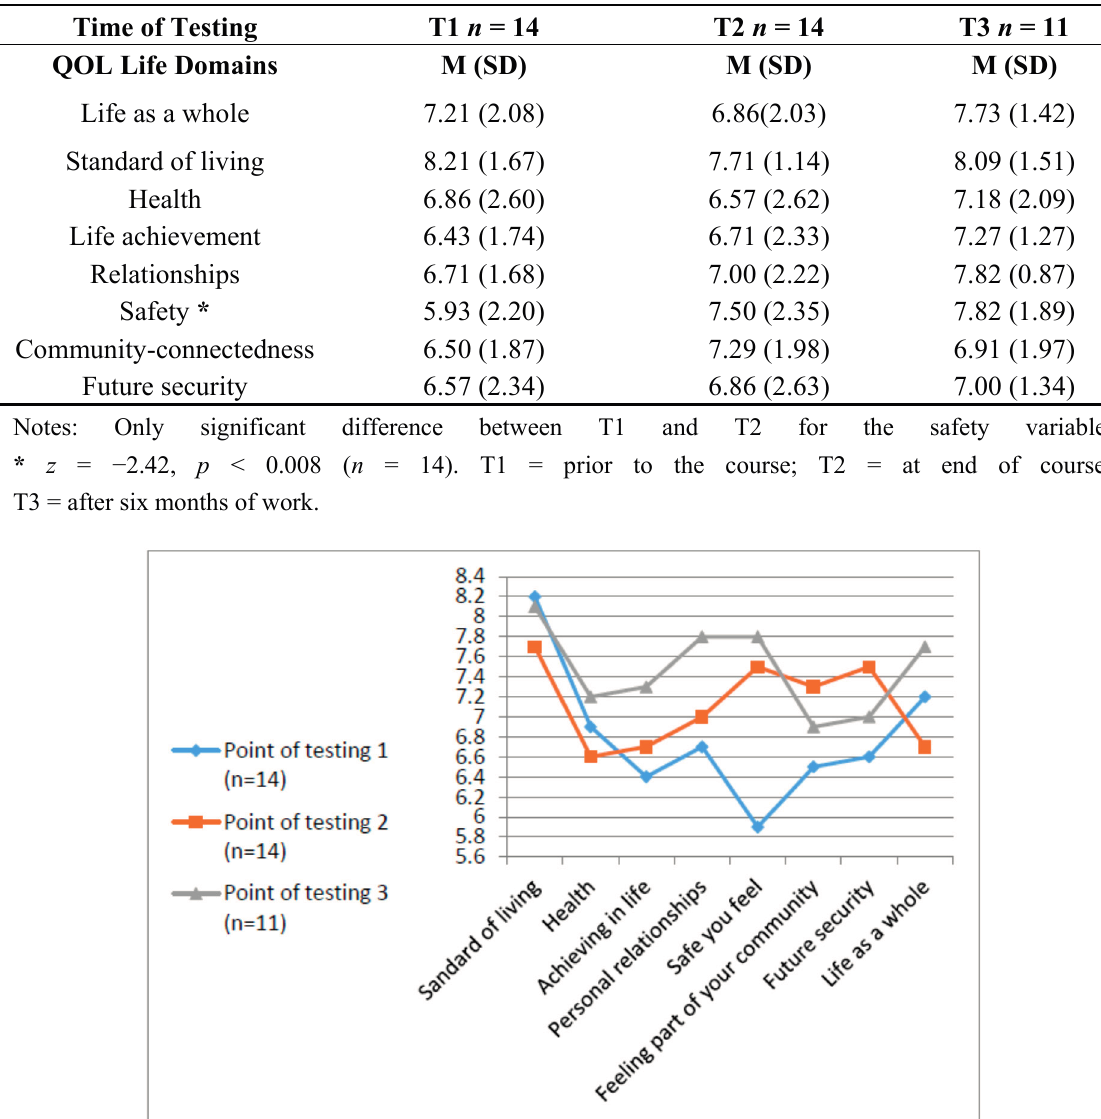
Table 2. Means and standard deviations of PWI at three points of testing (T1, T2, T3).